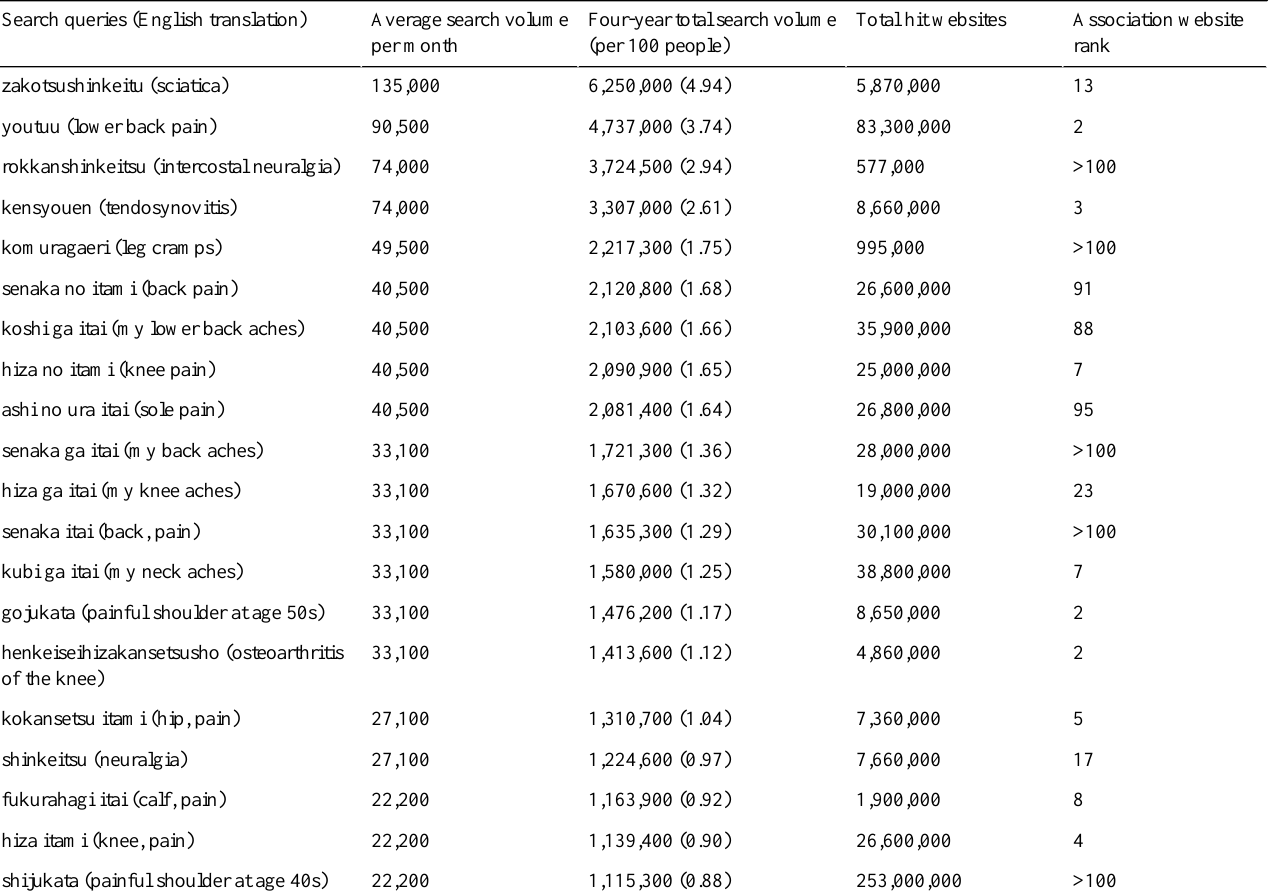
Table 2. Top 20 search queries in Japan.